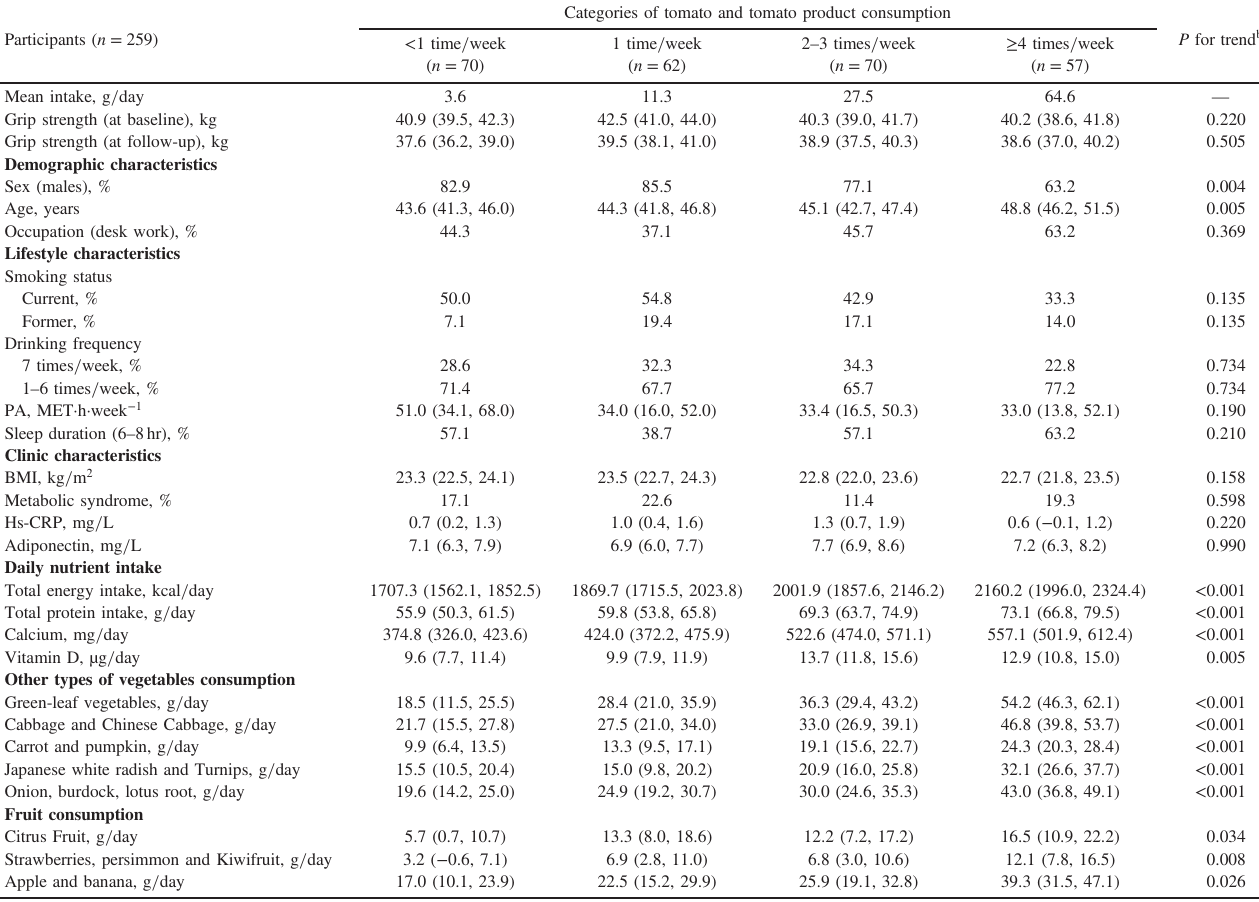
Table 1. Sex- and age-adjusted subject ’ s baseline characteristics according to frequency of consumption of tomatoes and tomato products